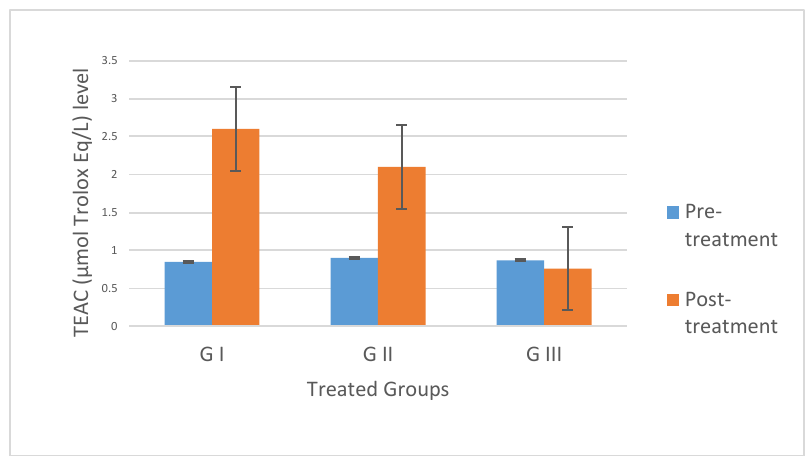
Figure 2: Trolox equivalent antioxidant capacity (TEAC) plasma values (µmol Trolox Eq/L) of tested groups I, II, and III, pre- and post-treatment. Group I: Patients administered Lavender oil, Group II: Patients administered Flax oil, Group III: Placebo control group.